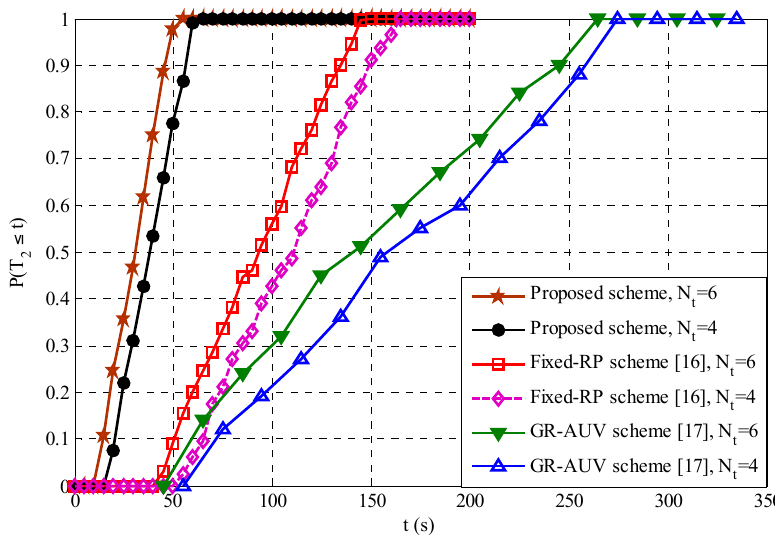
T . Figure 9. Cumulative distribution Probability of T 2 2